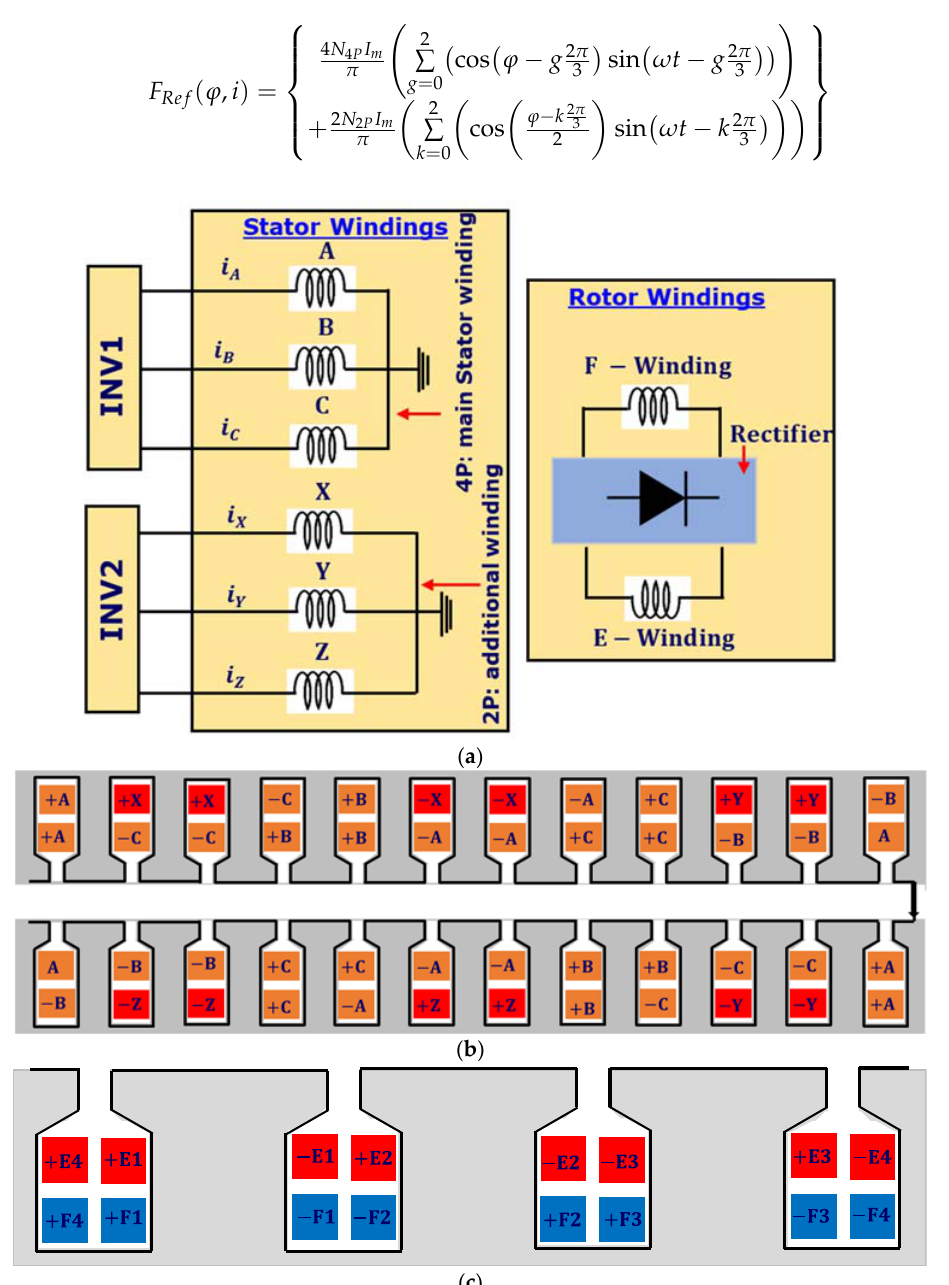
Figure 1. ( a ) Topology of reference machine, ( b ) armature winding configuration, ( c ) rotor winding configuration. ing